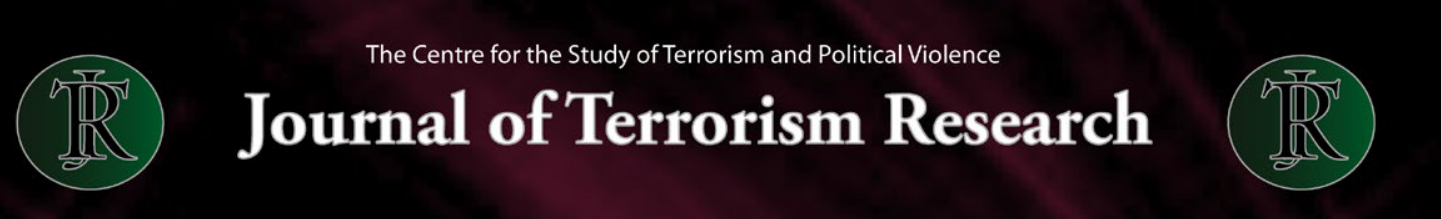
Figure 11: Op Green Rights IRC dialog talking about data leaks The purpose of leaked data is to expose corporate malfeasance, and Op Green Rights shows a strong interest communicate the Op Green Rights message to the wider